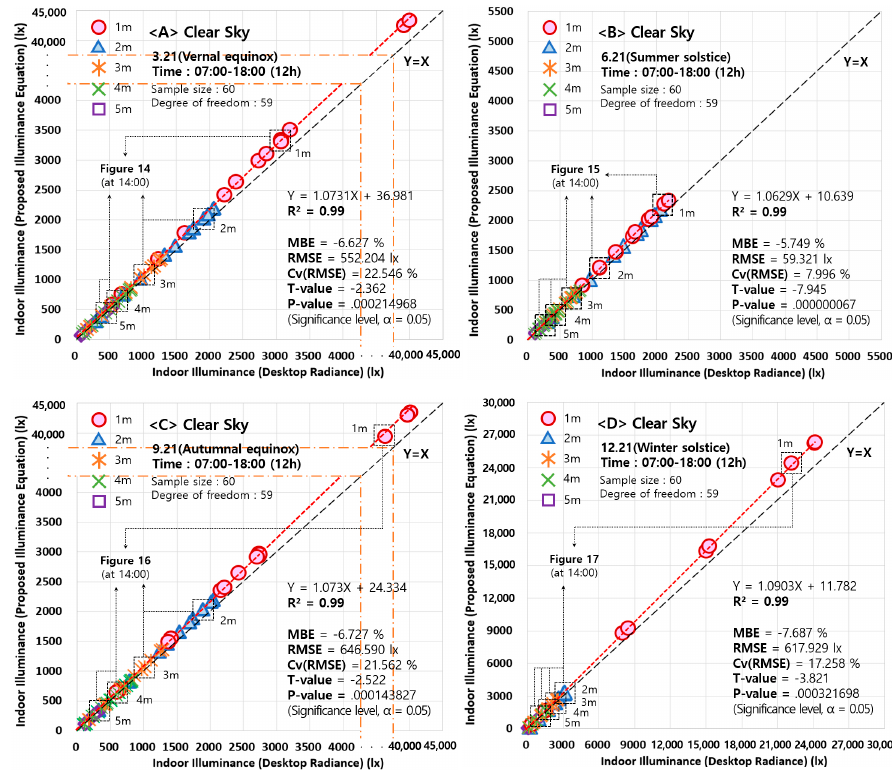
Figure 18. Comparison of indoor illuminance between the modified equation and Desktop Radiance in CIE clear sky ( A ) 3.21(07:00–18:00) ( B ) 6.21(07:00–18:00) ( C ) 9.21(07:00–18:00) ( D ) 12.21 (07:00–18:00).